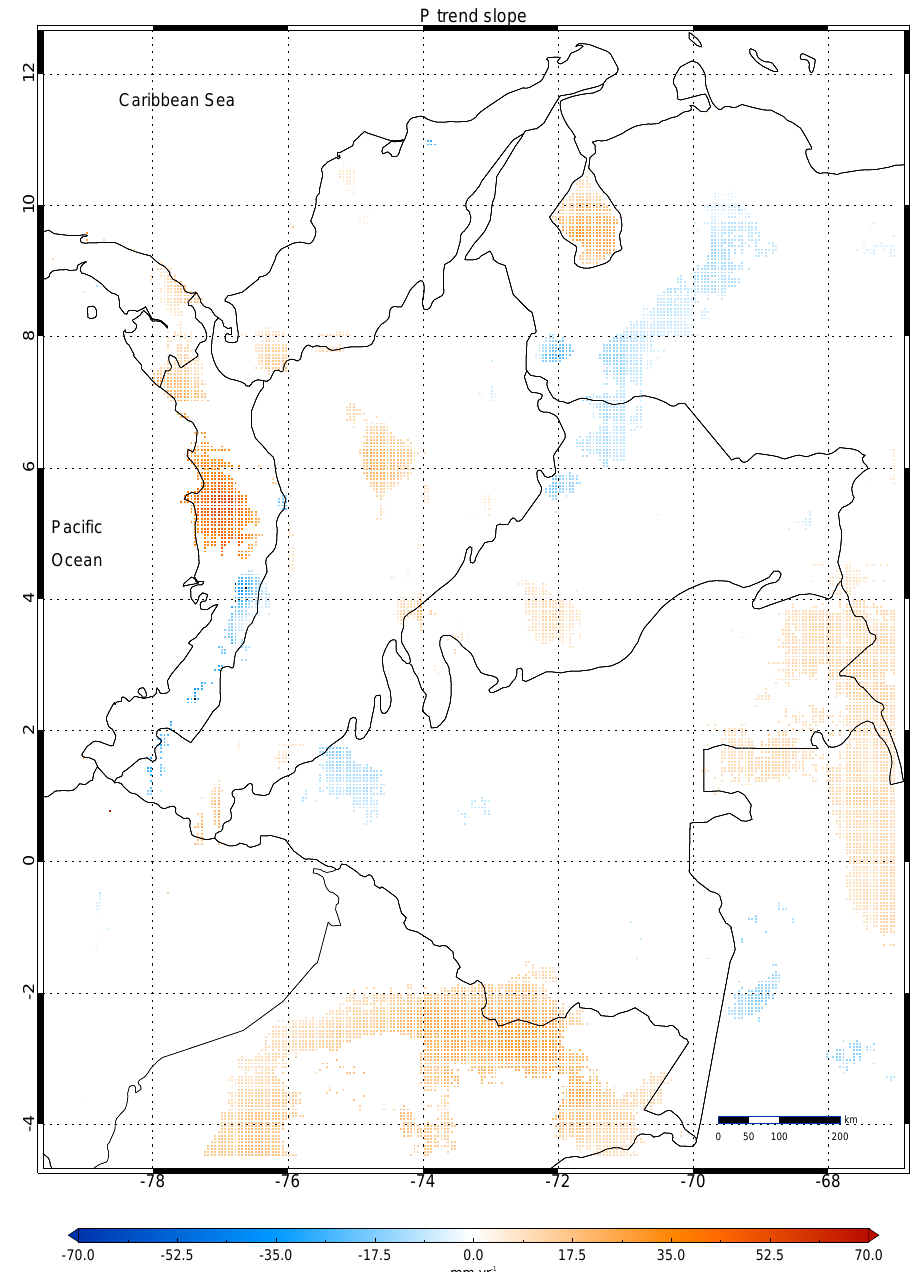
Figure 9. Map of the trend slope for P CHIRPS dataset. Non-significant trends are not plotted for CHIRPS. Color scale in